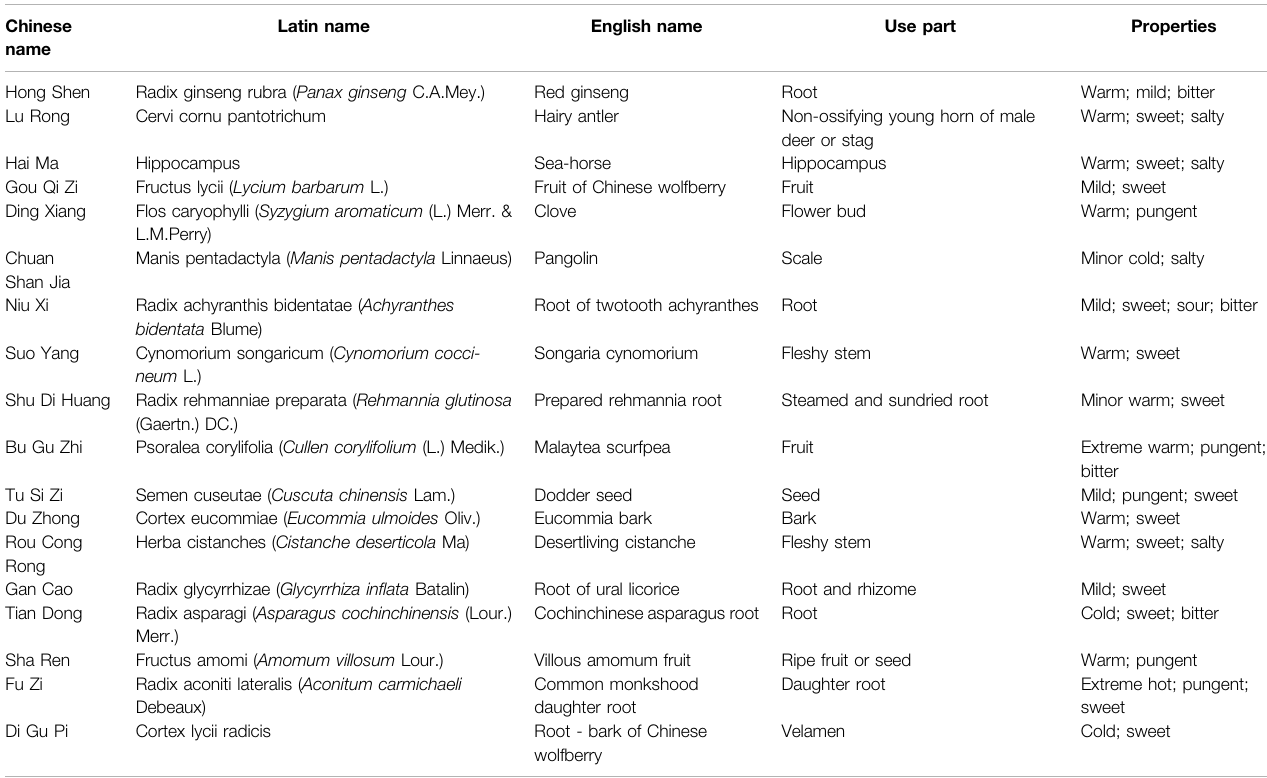
TABLE 1 | The main Chinese medicinal herbs contained in